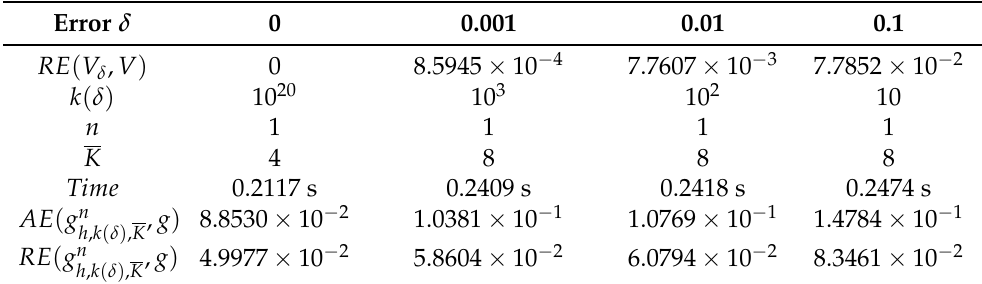
Table 2. Convergence of numerical results for circular region with noisy data V δ using mesh M 1 ( 774,1470 ) and ε = 10 − 3